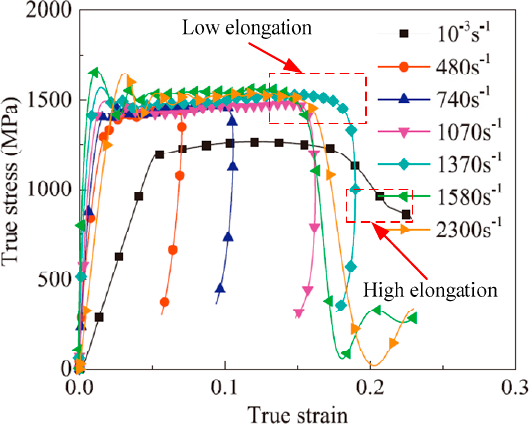
Figure 2. Compression stress-strain curves of Ti-55511 alloy in a wide range of strain rates at room temperature (Reprinted with permission from Ref. [39]. Copyright 2018, Mech. Mater.).